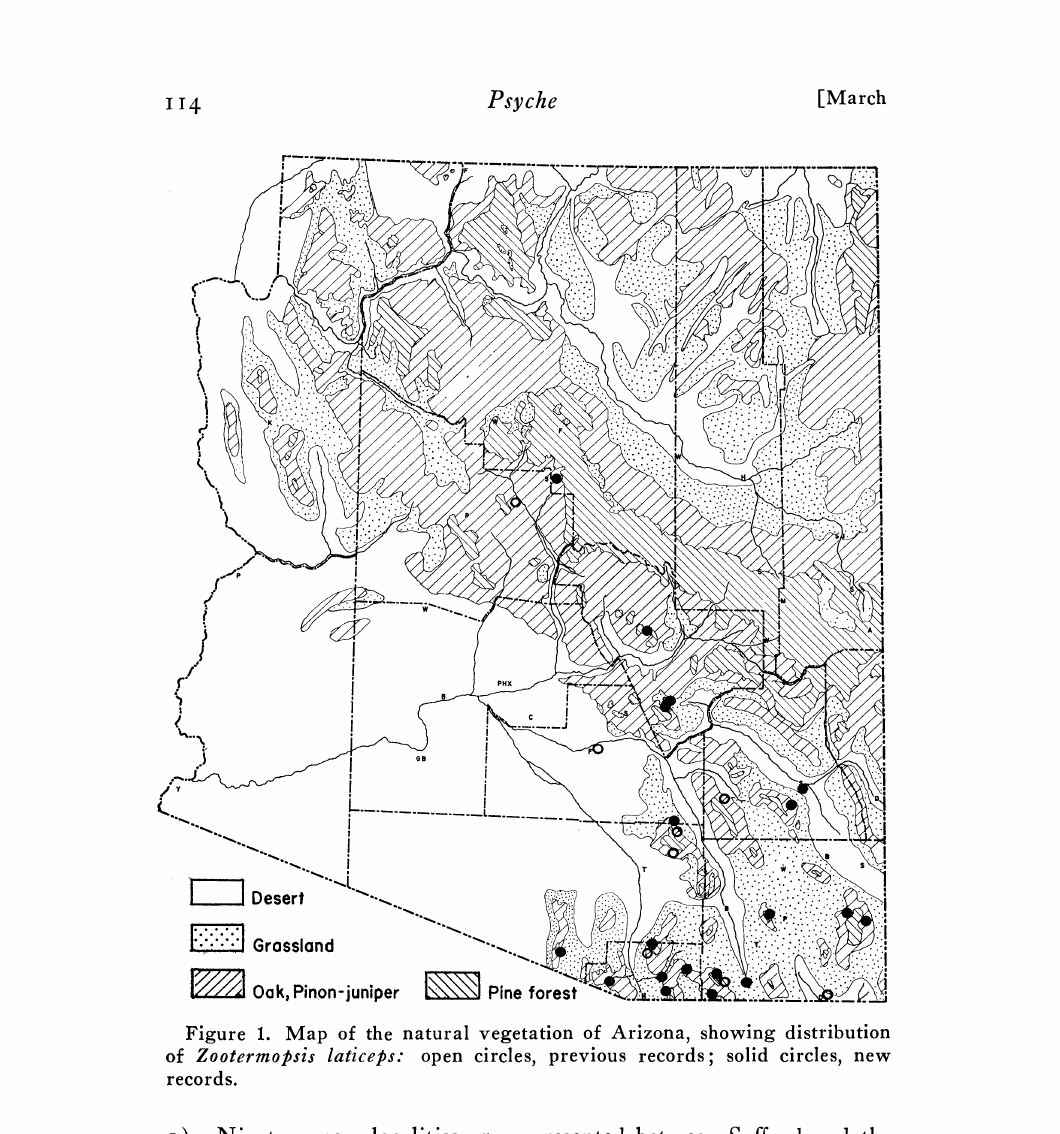
Figure 1. Map o the natural vegetation of Arizo.na, showing distribution of Zootermolsis laticeps: open circles, previous records; solid circles, new